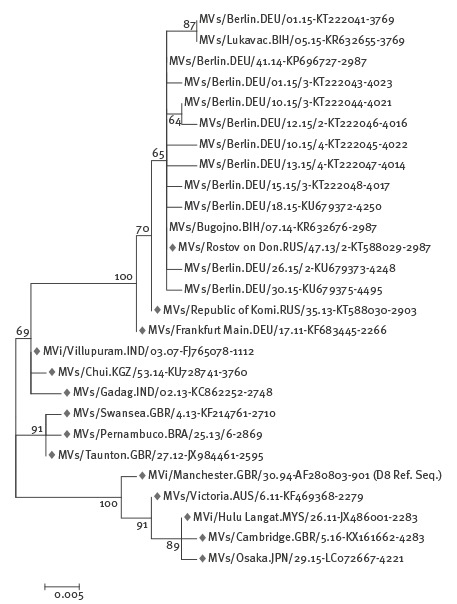
Phylogenetic relationship between the measles virus sequence variants detected in a large outbreak of measles in Berlin, August 2014–October 2015 (n = 351), a large outbreak in Bosnia and Herzegovina (2014–2015) and the World Health Organization Reference and Named Strains for measles virus genotype D8 (marked in grey)